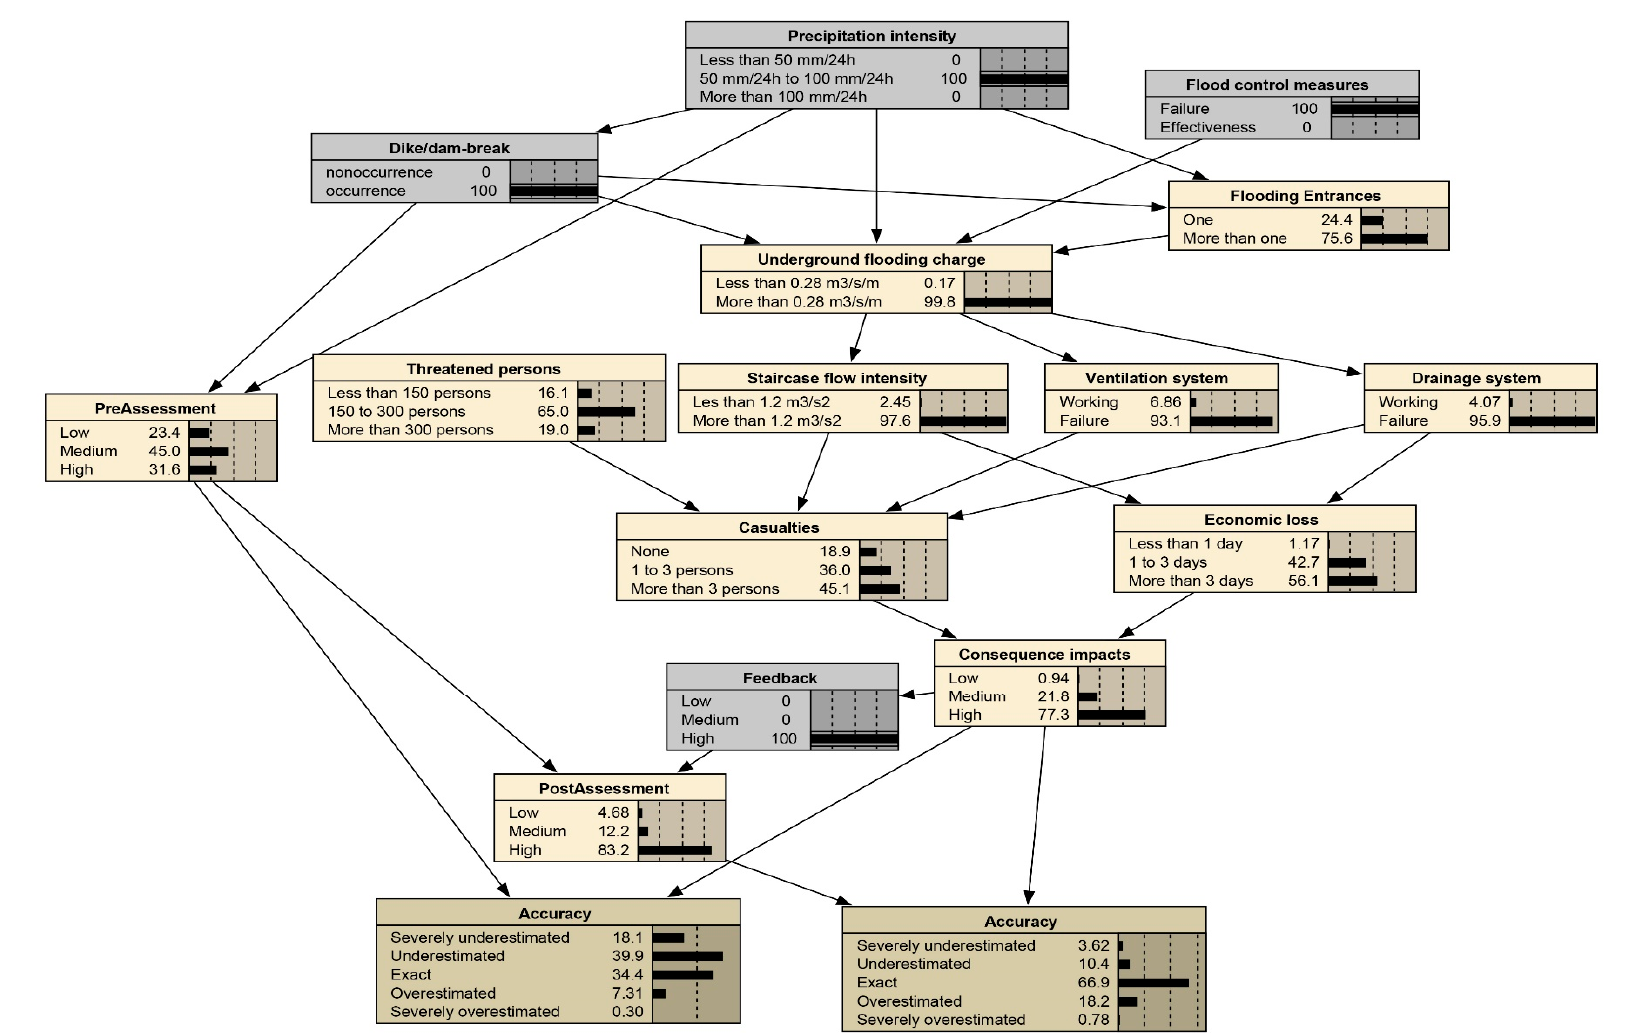
Figure 8. Inference results with feedback information.